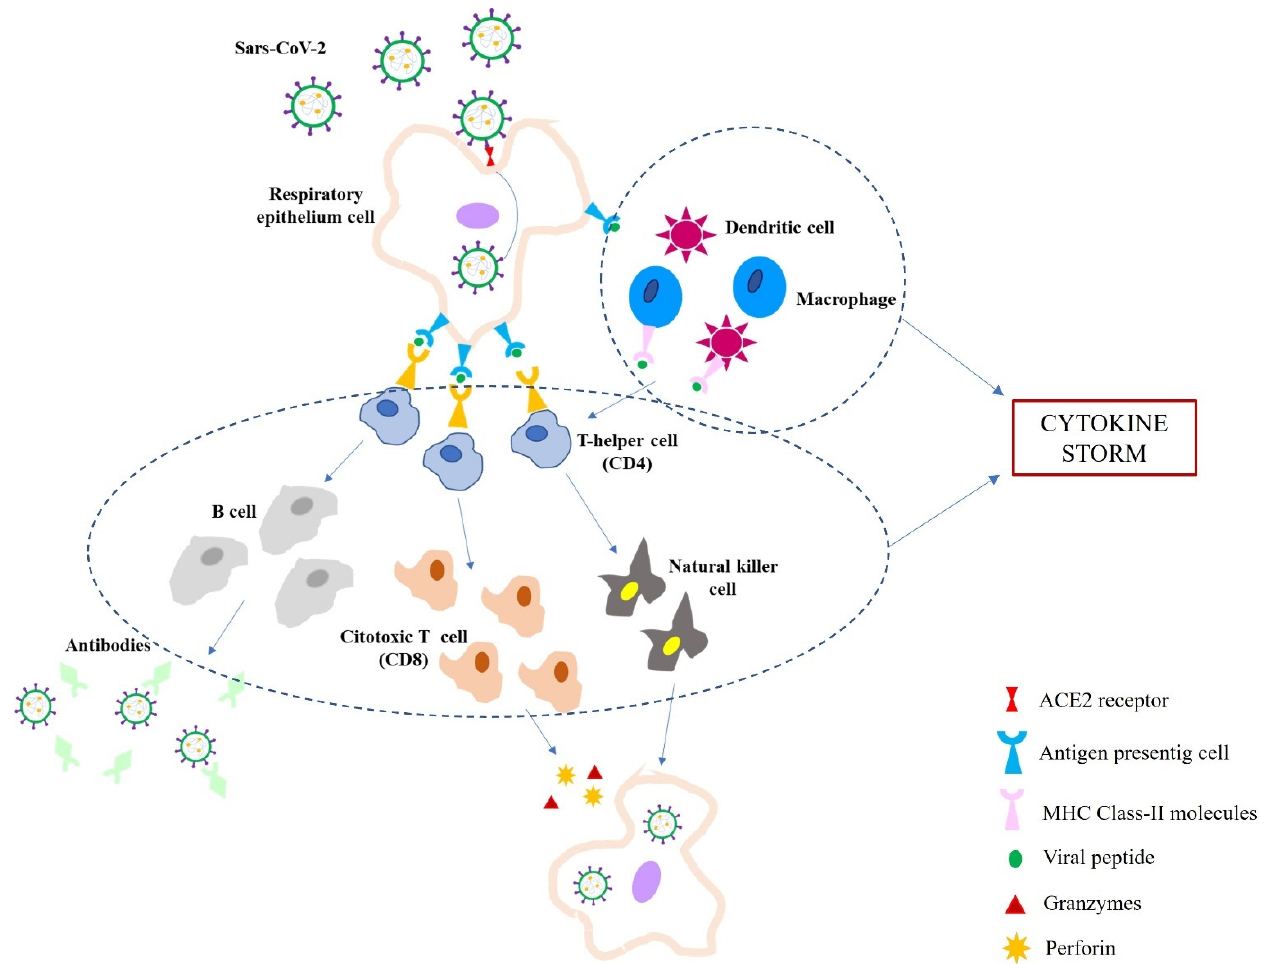
Figure 1. Schematic representation of Sars-CoV-2 infection immune response. Sars-CoV-2 enters the respiratory epithelium cell by the interaction of spike protein and ACE2 receptors; the virus is engulfed by APCs (antigen protein cells), which present viral antigens to T helper cells; dendritic cells and macrophages also recognize the whole virus and virus particle through MHC Class-II molecules and present viral peptides to T helper cells; T helper cells activate cytotoxic T cells and stimulate B cells; cytotoxic T cells produce perforin and granzymes to destroy the infected cell; stimulated B cells produce antibodies against Sars-CoV-2. Moreover, the activation of large numbers of white blood cells (T cells, B cells, NK cells, macrophages, dendritic cells, etc.) and resident tissue cells (i.e., epithelial and endothelial cells) determine the release of high numbers of pro-inflammatory cytokines (i.e., IL1B, IFN γ , IP10, and MCP-1) responsible for the so-called cytokine storm.